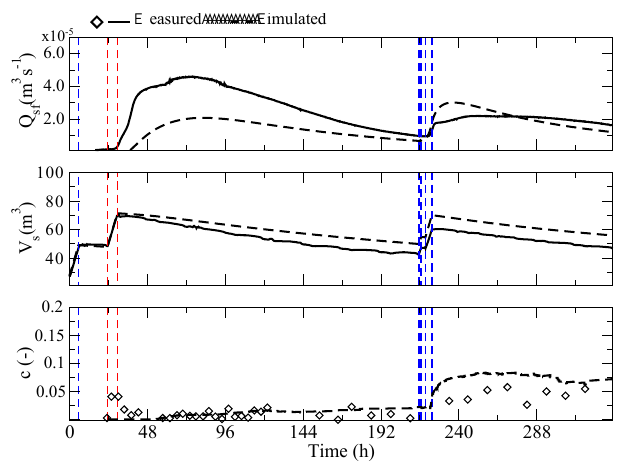
Figure 15. Performance of the model against integrated flow and transport responses (seepage face flow Q sf , total water storage V s , and average tracer concentration c at the seepage face) using the additional parameterization from the distributed analyses (spatially variable soil retention capacity, simulation l of Table 3). The vertical dashed lines indicate the timing of the three pulses of rain (red when the water is 2 H -enriched and blue when it is